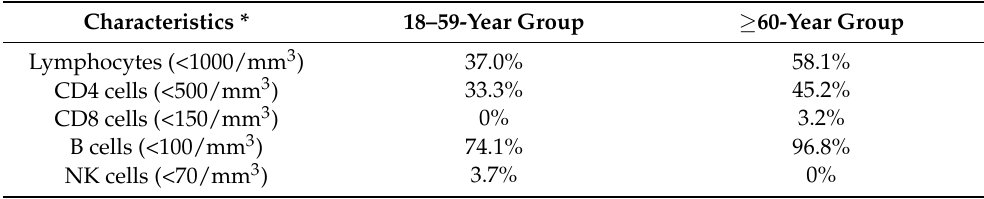
Table 3. Baseline characteristics of immune cells in the non-seroconversion group. Characteristics